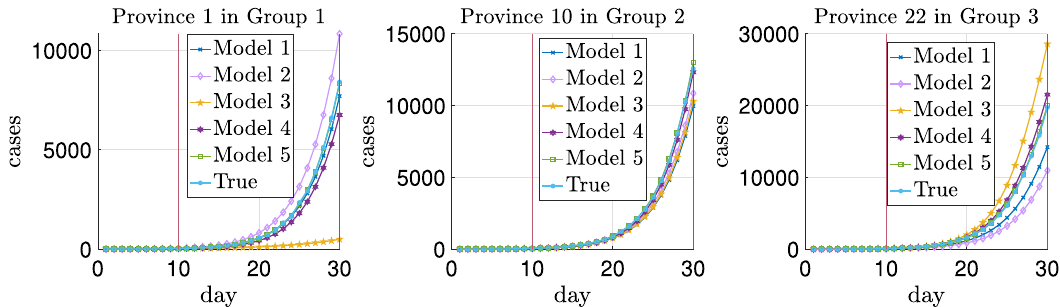
Figure 5. True and fitted trajectories for the simulated data in the three provinces chosen from the total thirty provinces. The vertical lines show the threshold of training-testing split. For Model 5, µ ∗ = 10 1.8 , at which the averaged validation errors over replicas are minimized (as shown in Fig. 7).